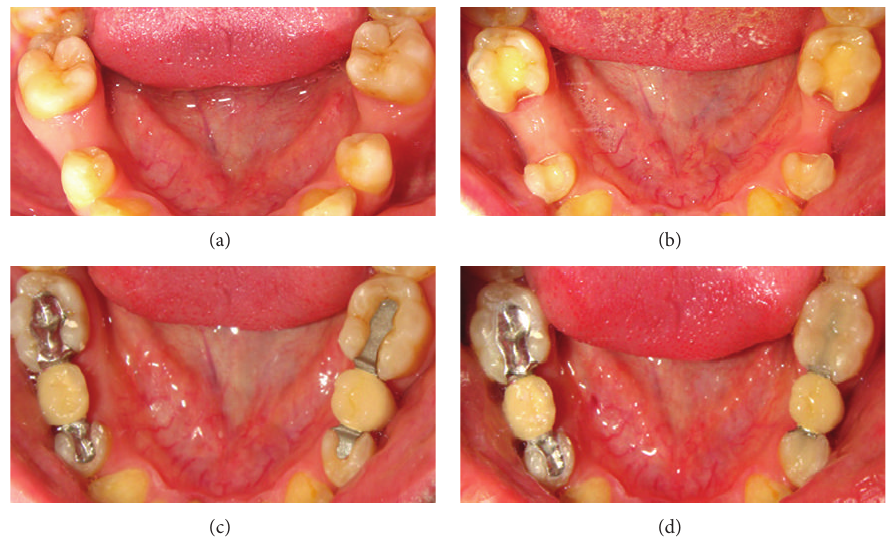
Figure 3: (a) Preoperative intraoral view illustrating loss of mandibular second premolars in a 24-year-old male patient. (b) Intraoral occlusal view illustrating the abutment teeth prepared to receive the metal-ceramic IRFDPs: (left) the modified design and (right) the traditional design. (c) Try-in of the IRFDPs before cementation: (left) the modified design and (right) the traditional design. (d) Intraoral occlusal view of the two IRFDPs after cementation: (left) the modified design and (right) the traditional design.